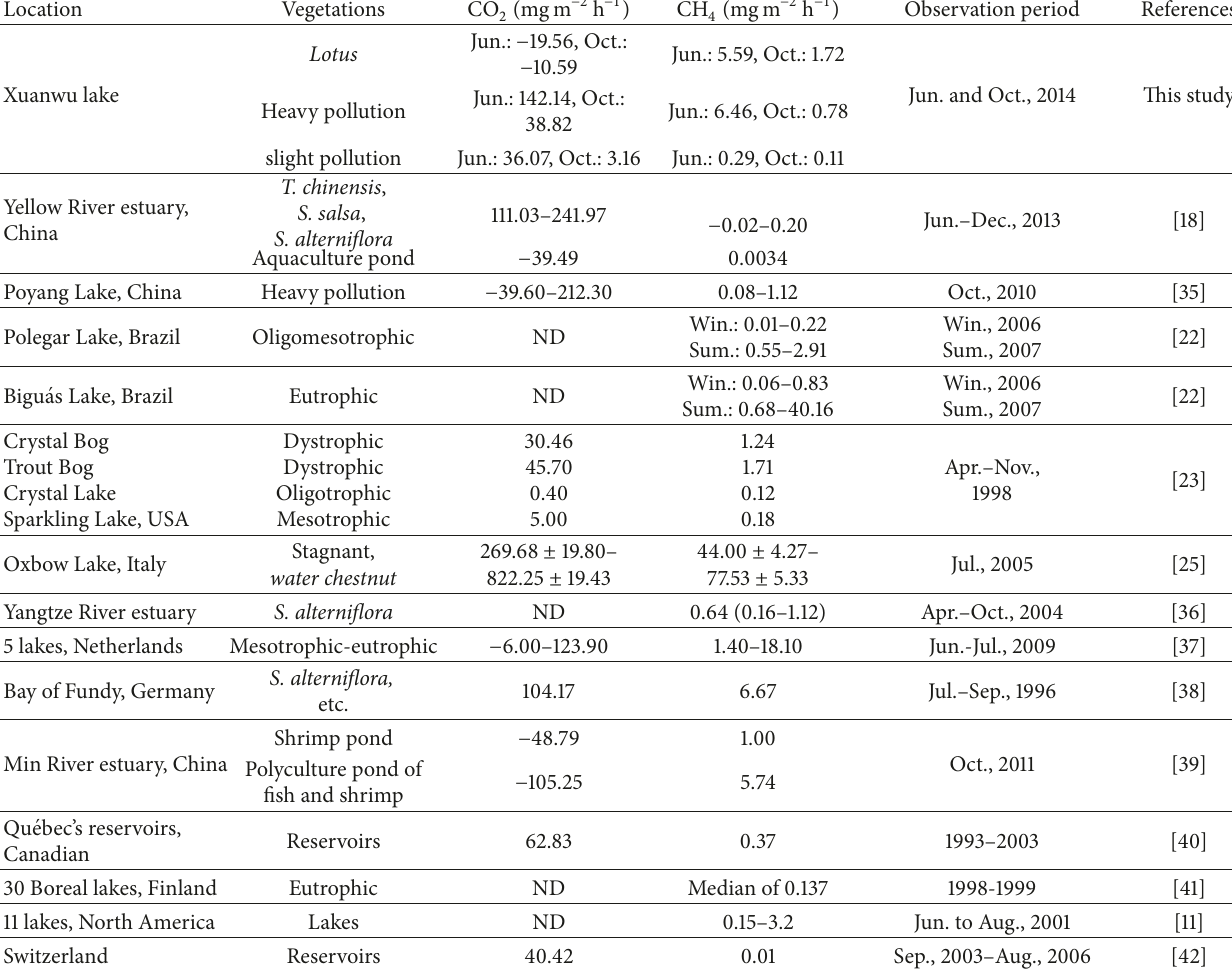
Table 9: CO 2 and CH 4 fluxes from this study and